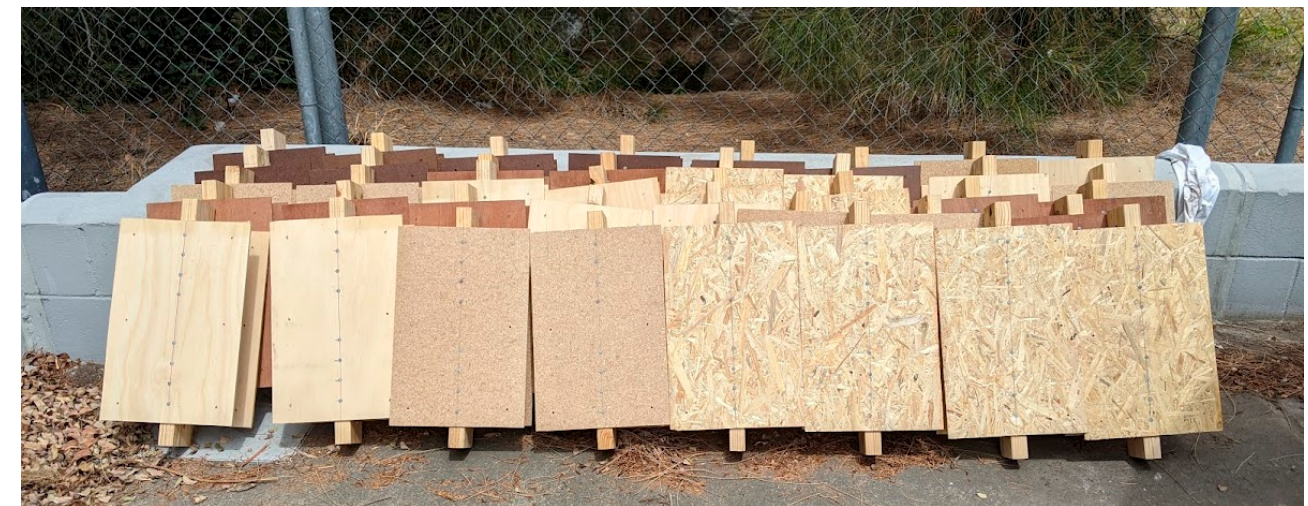
Figure 2. Exposure of weathered specimens.